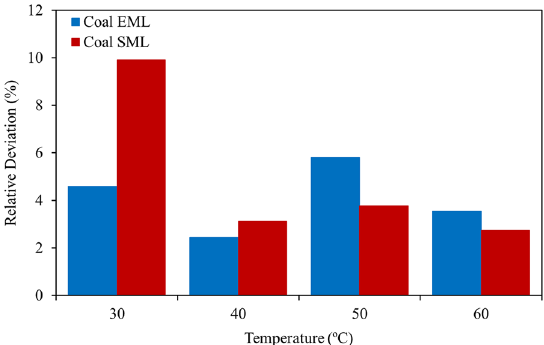
Fig. 11 Statistical comparison of experimental and theoretical maxi- mum flue gas sorption capacity for a Coal EML and b Coal SML at 30 ºC, 40 ºC, 50 ºC, and 60 ºC